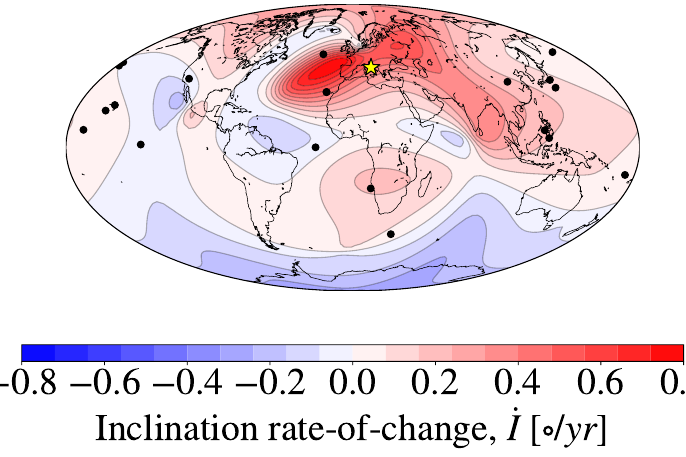
Figure 11. Inclination rate of change calculated via first differences from the realisations of the IM- MAB4 at 774.4 and 774.5 ka. The black dots indicate the location of the paleomagnetic measurements used to constrain the IMMAB4 model (see Leonhardt and Fabian [21] for more details). The yellow star marks the SUL location, to facilitate the comparison with Figure